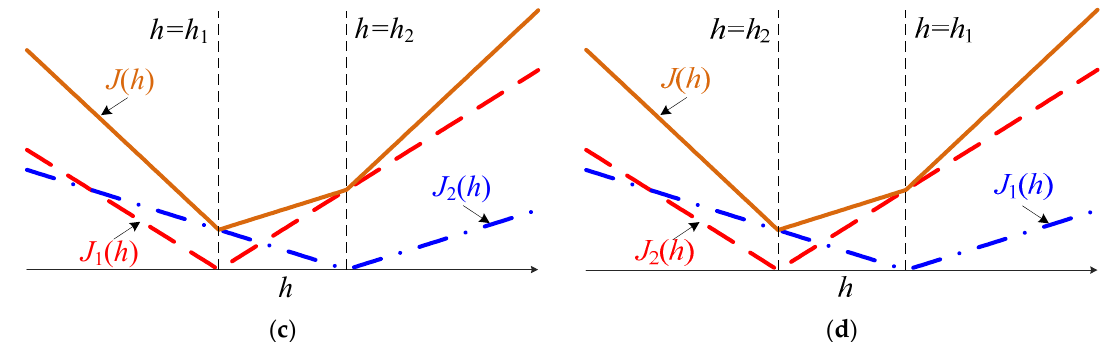
Figure 3. Functional curves of J ( h ), J 1 ( h )and J 2 ( h ): ( a ) a 2 > a 1 , h 1 < h 2 . ( b ) a 2 < a 1 , h 1 > h 2 . ( c ) a 2 < a 1 , h 1 < h 2 . ( d ) a 2 > a 1 , h 1 > h 2 .